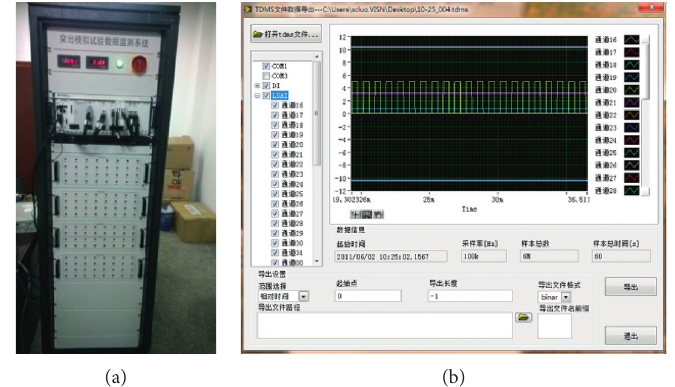
Figure 6: Data acquisition system. (a) Hardware. (b) Software.